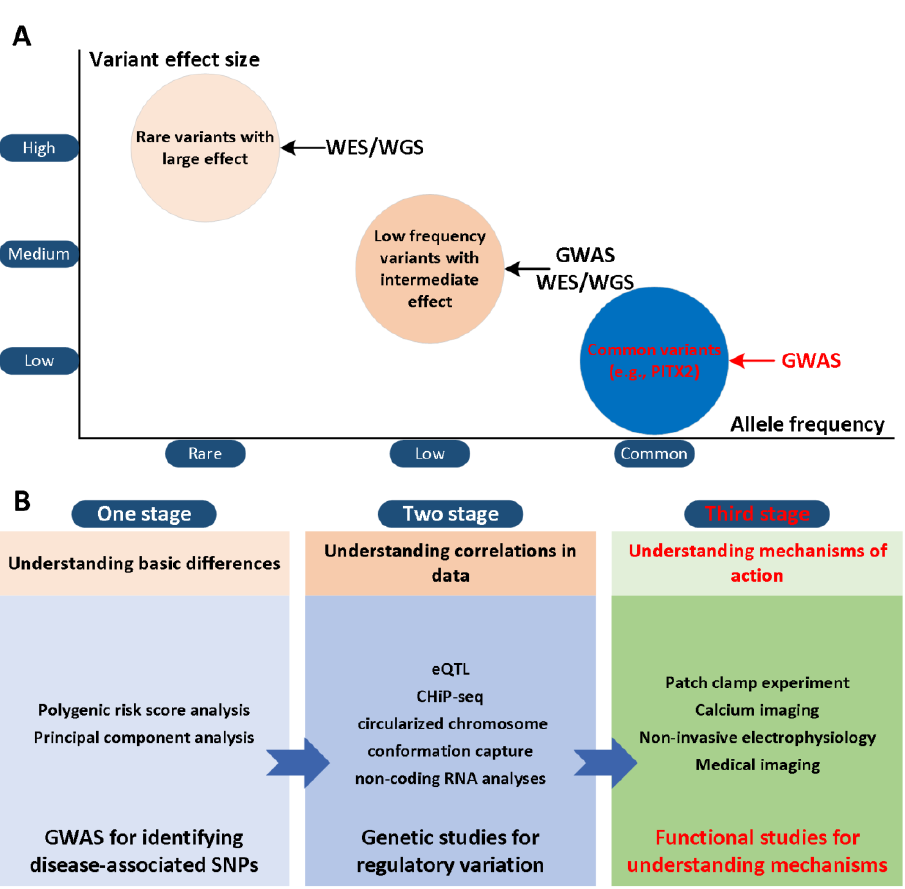
Figure 1. Role of genes in AF from GWAS locus to gene and mechanism. ( A ) GWAS for atrial fibrillation have explored common variants and established many associations with modest to